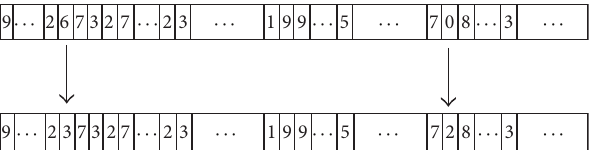
Figure 8: Mutation operation.